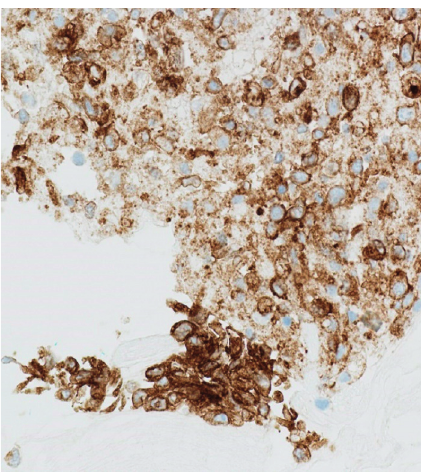
Figure 4: Immunocytochemistry staining showing strong posi- tivity for